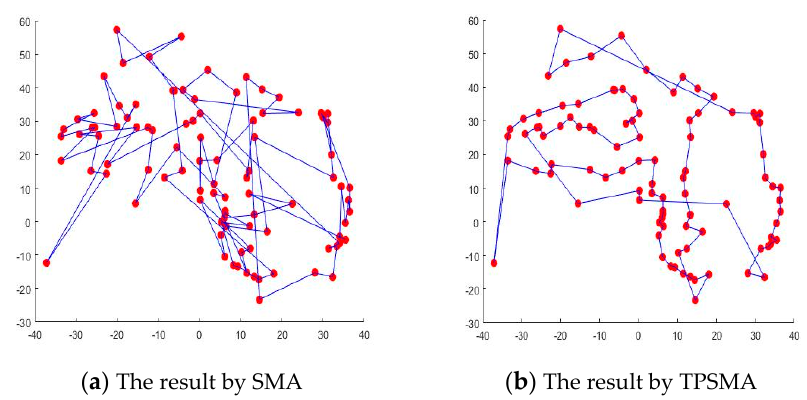
Figure 7. The simulation of eil51.